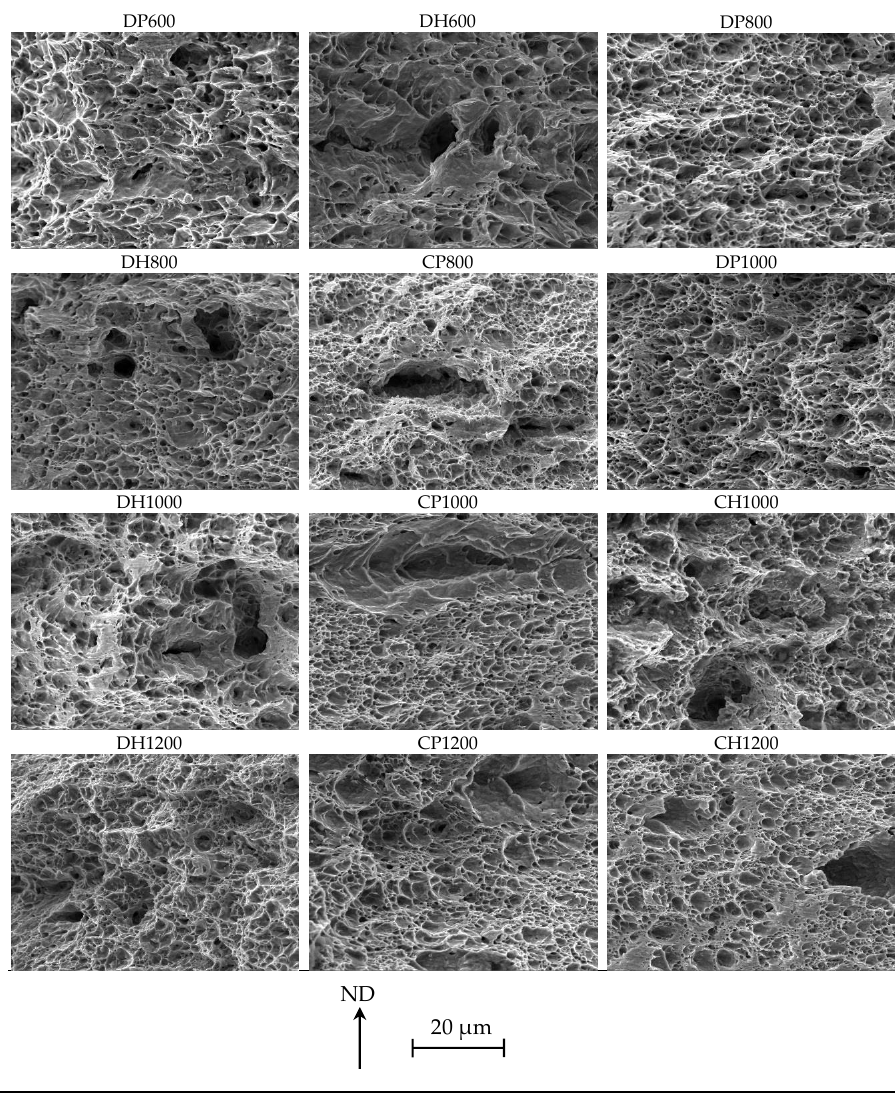
Figure A7. Local formability: Correlation between true thickness strain at fracture ε 3 f and hole expansion ratio HER. Molecules 2018 , 23 , x 10 of 10 Table A19. Fracture surfaces A 80mm -specimens.